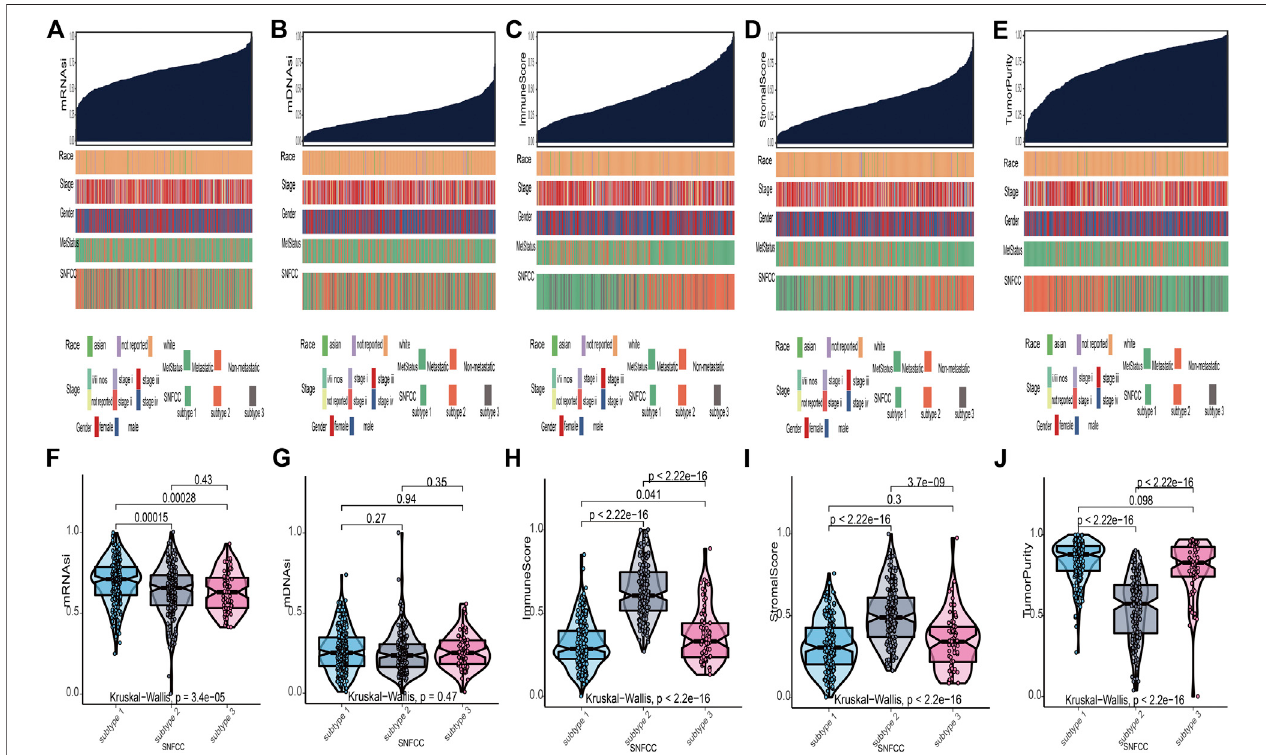
FIGURE2| Clinicalvariablesassociatedwiththestemnessindices(mRNAsiandmDNAsi)andtumormicroenvironmentindices(immunescore,stromalscore,and tumor purity) in melanoma. (A) : the association between clinical variables (race, stage, gender, metastatic status, and subtype) and mRNAsi; (B) : the association between clinical variables and mDNAsi; (C) : the association between clinical variables and immune score; (D) : the association between clinical variables and stromal score; (E) : the association between clinical variables and tumor purity. Columns represent samples sorted by score of indices from low to high (top row) . Rows represent clinical variables. (F) : boxplots of mRNAsi in individual samples strati fi ed by subtype; (G) : boxplots of mDNAsi in individual samples strati fi ed by subtype; (H) : boxplotsofimmunescoreinindividualsamplesstrati fi edbysubtype; (I) :boxplotsofstromalscoreinindividualsamplesstrati fi edbysubtype; (J) :boxplotsoftumorpurity in individual samples strati fi ed by